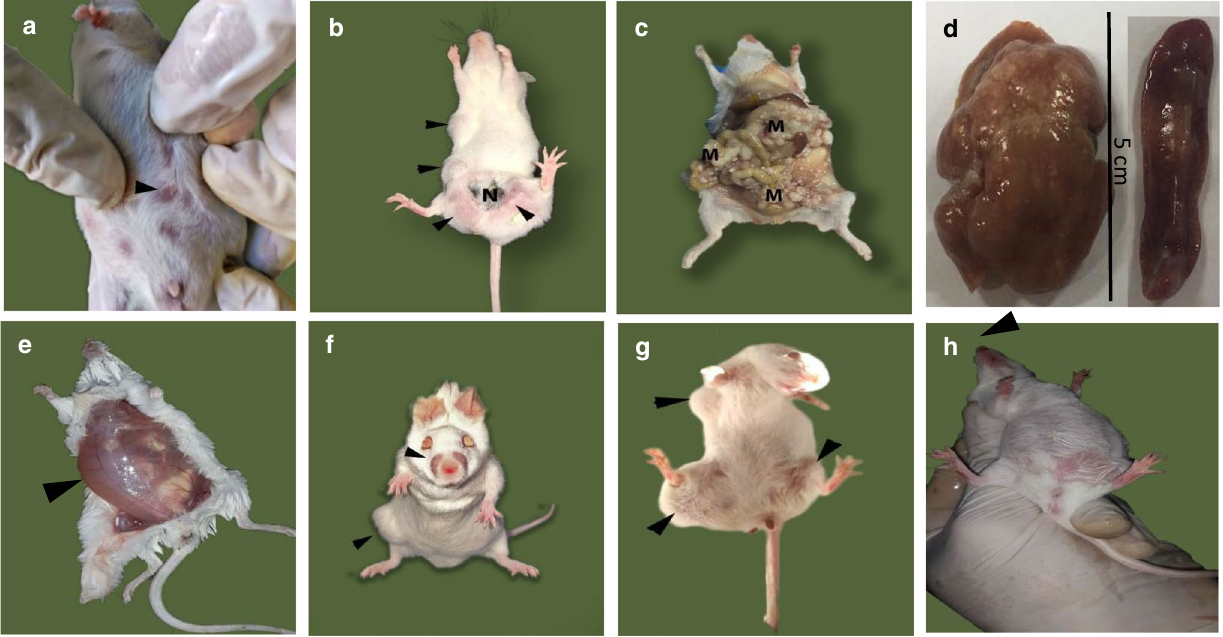
Fig. 1 Effect on the macroscopic examination of animals. a Control group showing normal nibbles (black arrow). b – d DMBA (p.o.) group showing tumors (black arrows in b with central necrosis N), metastasis (M in c ) and hepatosplenomegaly ( d ). e DMBA (i.p.) group showing fluid accumulation in peritoneal cavity. f DMBA/BFB group showing nasal hair loss and small tumor (black arrows). g DMBA/TAM group showing tumors (black arrows). h BFB group showing nasal hair loss (arrow)